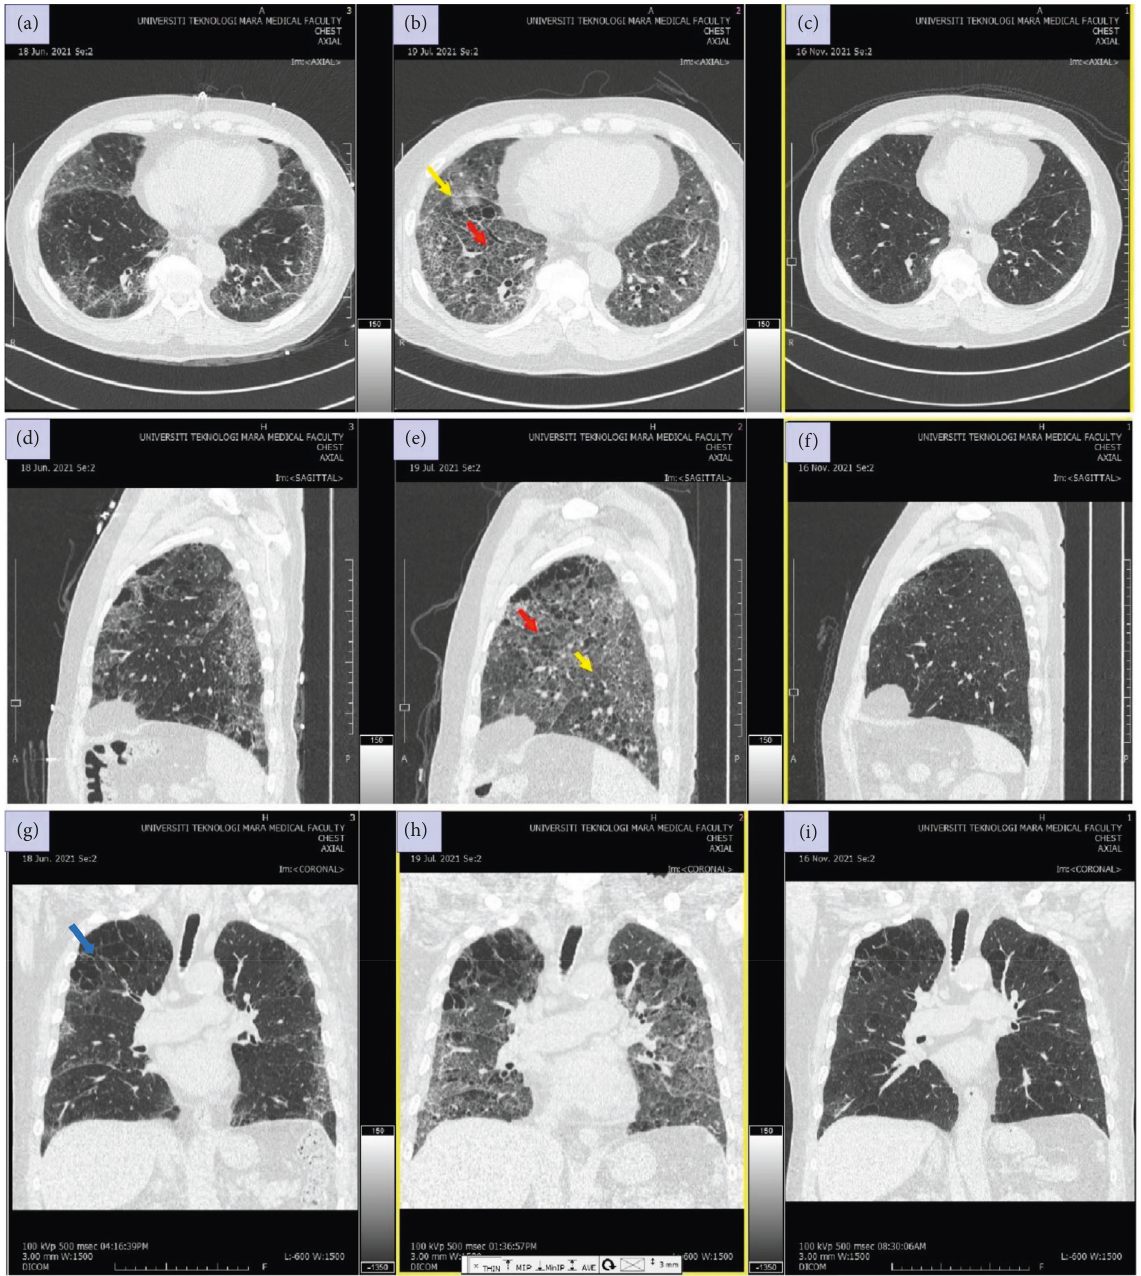
Figure 1: The sequences of CT thorax at day 10 of COVID-19 illness (a–c) showed moderate GGO with organizing pneumonia in the background of emphysematous lung (blue arrow). Second CT thorax at day 42 post COVID-19 infection (d–f) showed worsening bilateral ground glass opacity with reticulations and crazy paving pattern (red arrow) most prominent at bilateral lower lobes. There is also reduction in lung volume with displaced fissures (yellow arrow). Third CT thorax at 5 months post COVID-19 infection (g–i) showed significant improvement of GGO with residual reticulations in apical region and lung